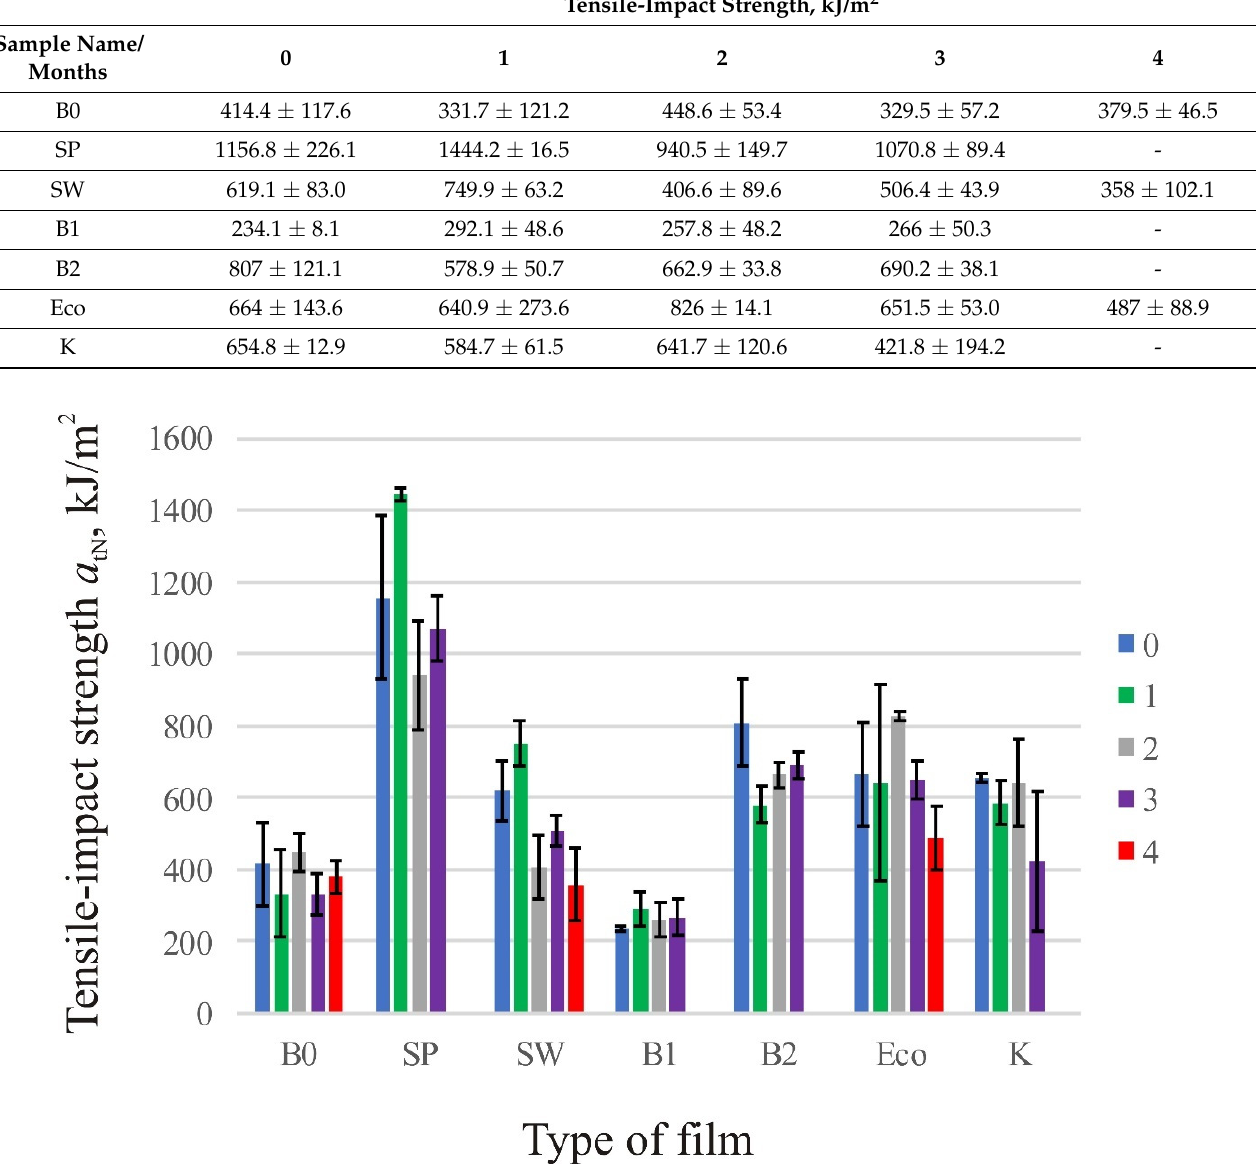
Figure 6. Tensile-impact strength of the film samples in the period of 0, 1, 2, 3, and 4 months. The figure also shows the error bars through the standard deviation.